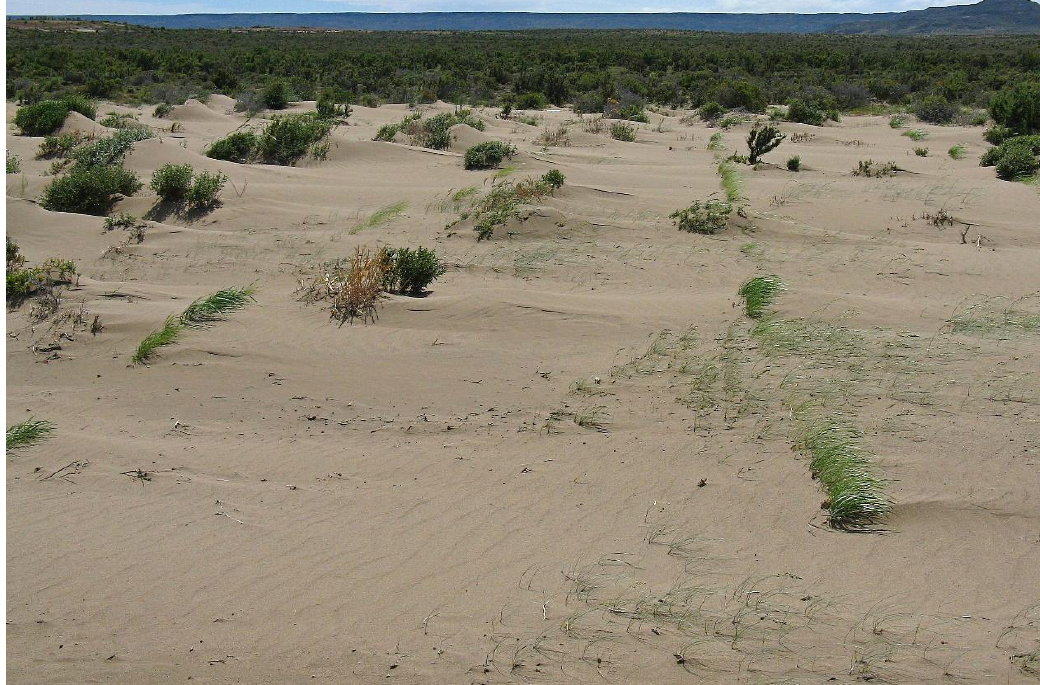
Figure 1. An example of a process of change: Active wind erosion destroying a vegetated area used for extensive sheep grazing in Chubut province, Patagonia, Argentina.